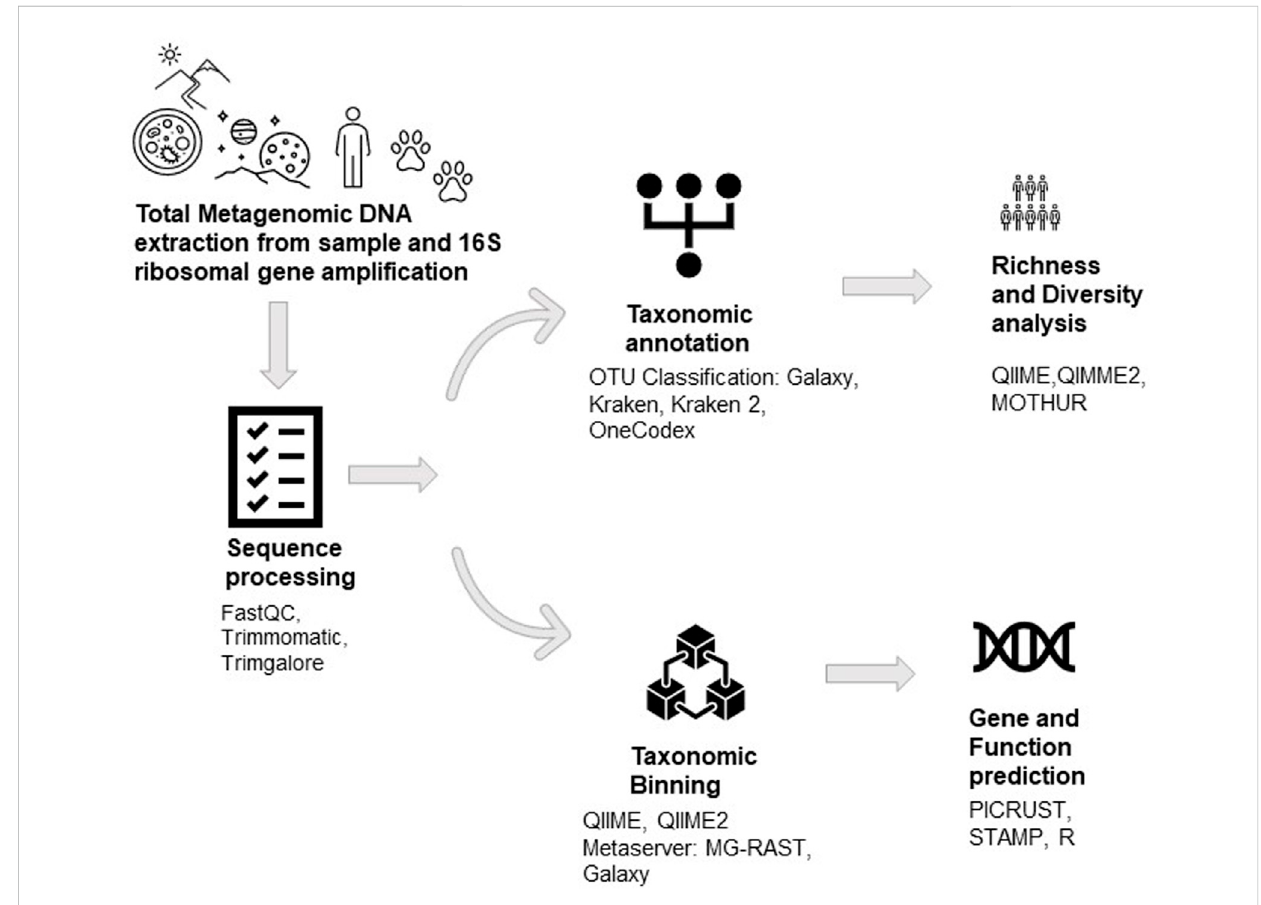
FIGURE 3 The work fl ow of Metagenomic DNA